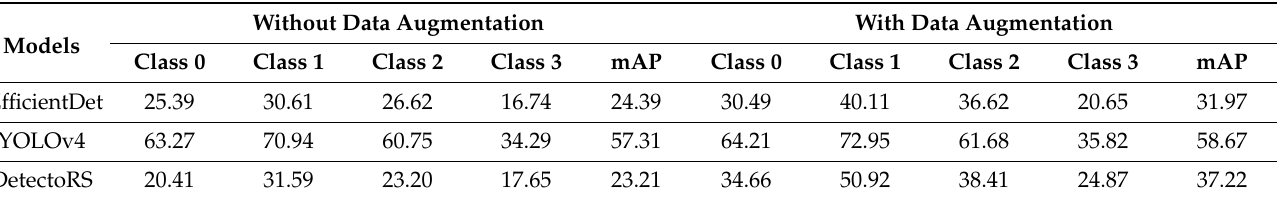
Table 4. Effects of data augmentation.